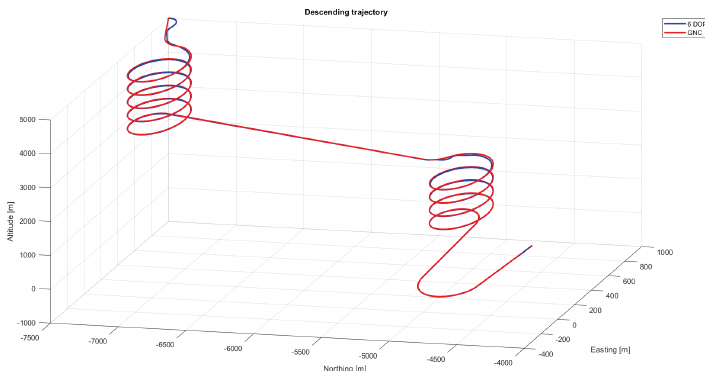
Figure 15. Overall 6 DOF trajectory of the parafoil with control saturation and no wind.